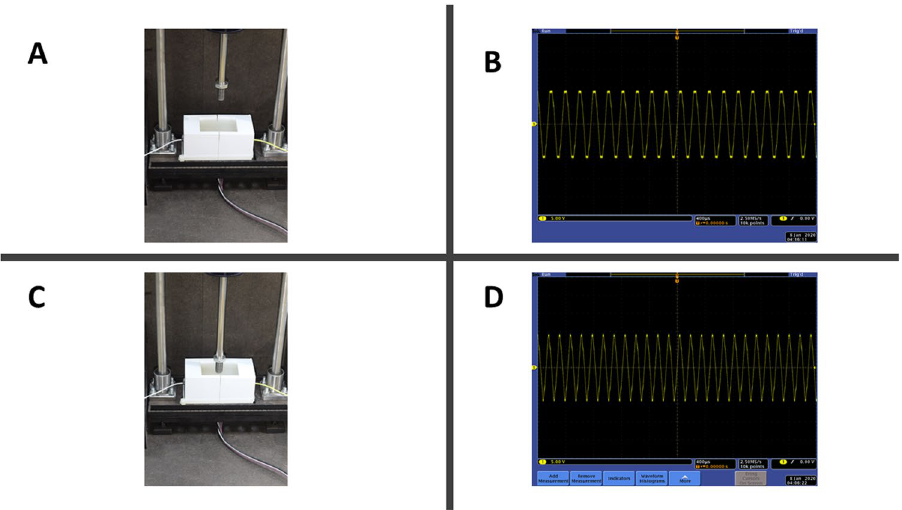
Figure 3. View of the experimental setup and the experiment results. In ( A ) the stroke is stretching yet did not reach the surface of the soft silicone rubber structure. The oscillation in ( B ) shows to be around 4 kHz before the contact moment. ( C ) shows after loading force on the soft structure leading to a rise in the frequency recorded as clear in ( D